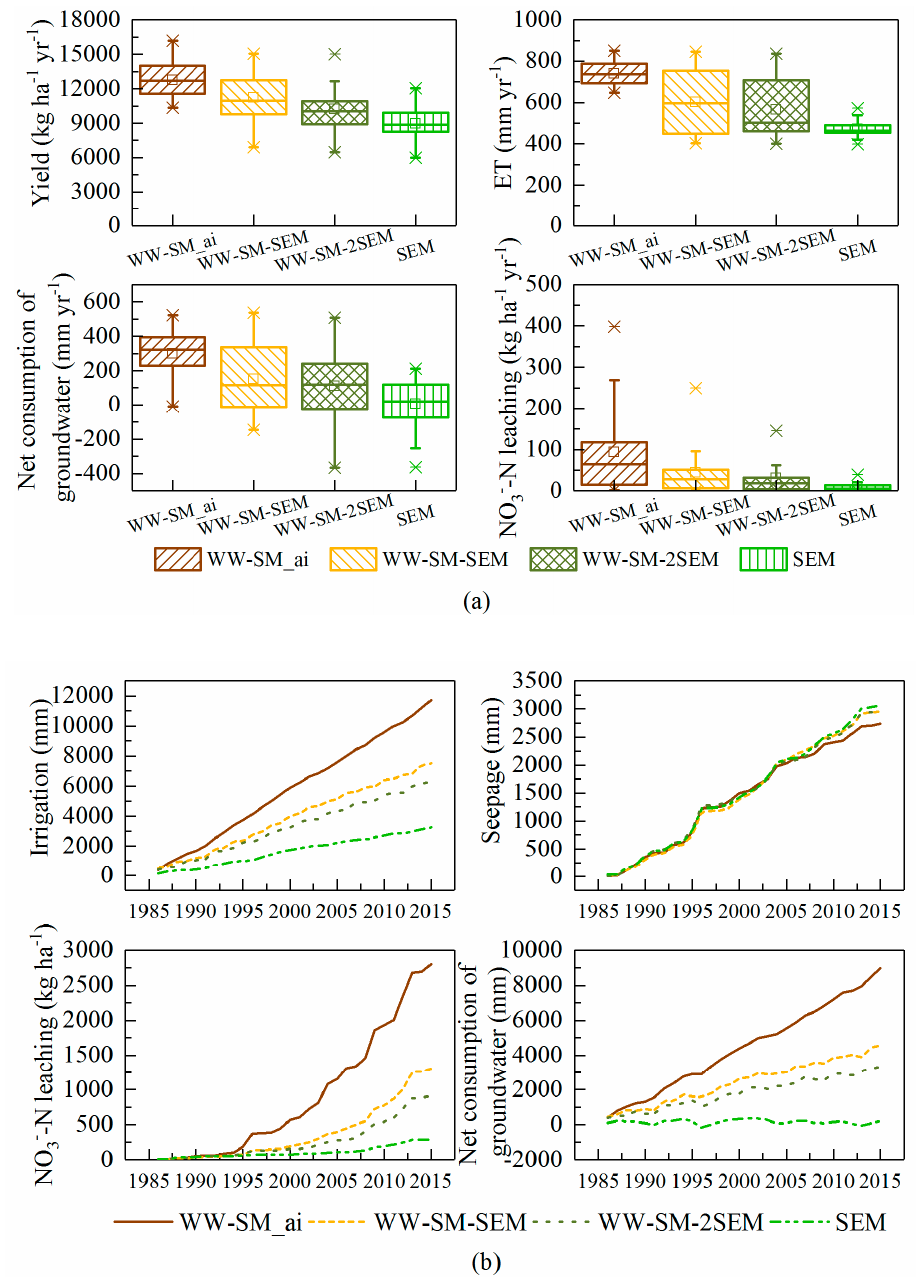
Figure 6. Box plots ( a ) of the simulated yield, evapotranspiration (ET), net consumption of groundwater, and NO 3 − -N leaching; and graphs ( b ) of accumulation of the simulated seepage, irrigation, net consumption of groundwater, and NO 3 − -N leaching of the local rotation system, WW-SM_ai, and three alternative cropping systems, WW-SM-SEM, WW-SM-2SEM, and SEM by the RZWQM2 model under auto-irrigation. Note: WW-SM_ai, WW-SM-SEM, WW-SM-2SEM, and SEM are the winter wheat–summer maize rotation system, with two harvests in one year; the winter wheat–summer maize and fallow–early maize system, with three harvests in two years; the winter wheat–summer maize and double fallow–early maize system, with four harvests in three years; and the single early maize system with one harvest per year.